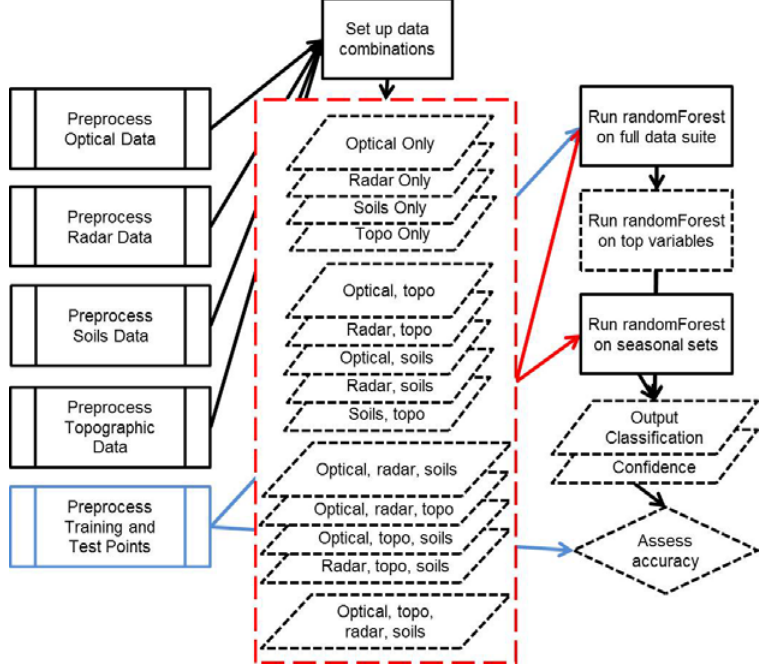
Figure 2. Data process flow. Preprocessing of input datasets and reference point data (shown in blue) are in the left-hand column. Combinations of datasets used to perform random forest (shown in red), along with generation of the output classification, confidence maps, and accuracy assessment are referenced by boxes in the right-hand